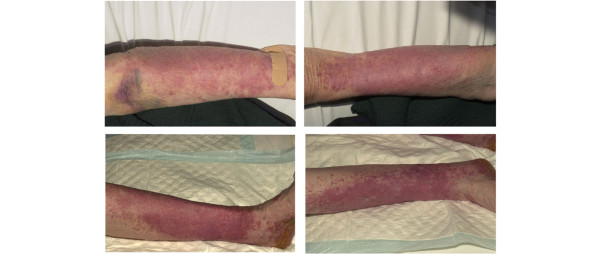
Eczematous drug-related eruption a patient with rheumatoid arthritis after infliximab therapy: Eczematous eruptions on the left arm (top left) and right arm (top right) and erythematous eruptions with purpura on the left leg (bottom left) and right leg (bottom right).